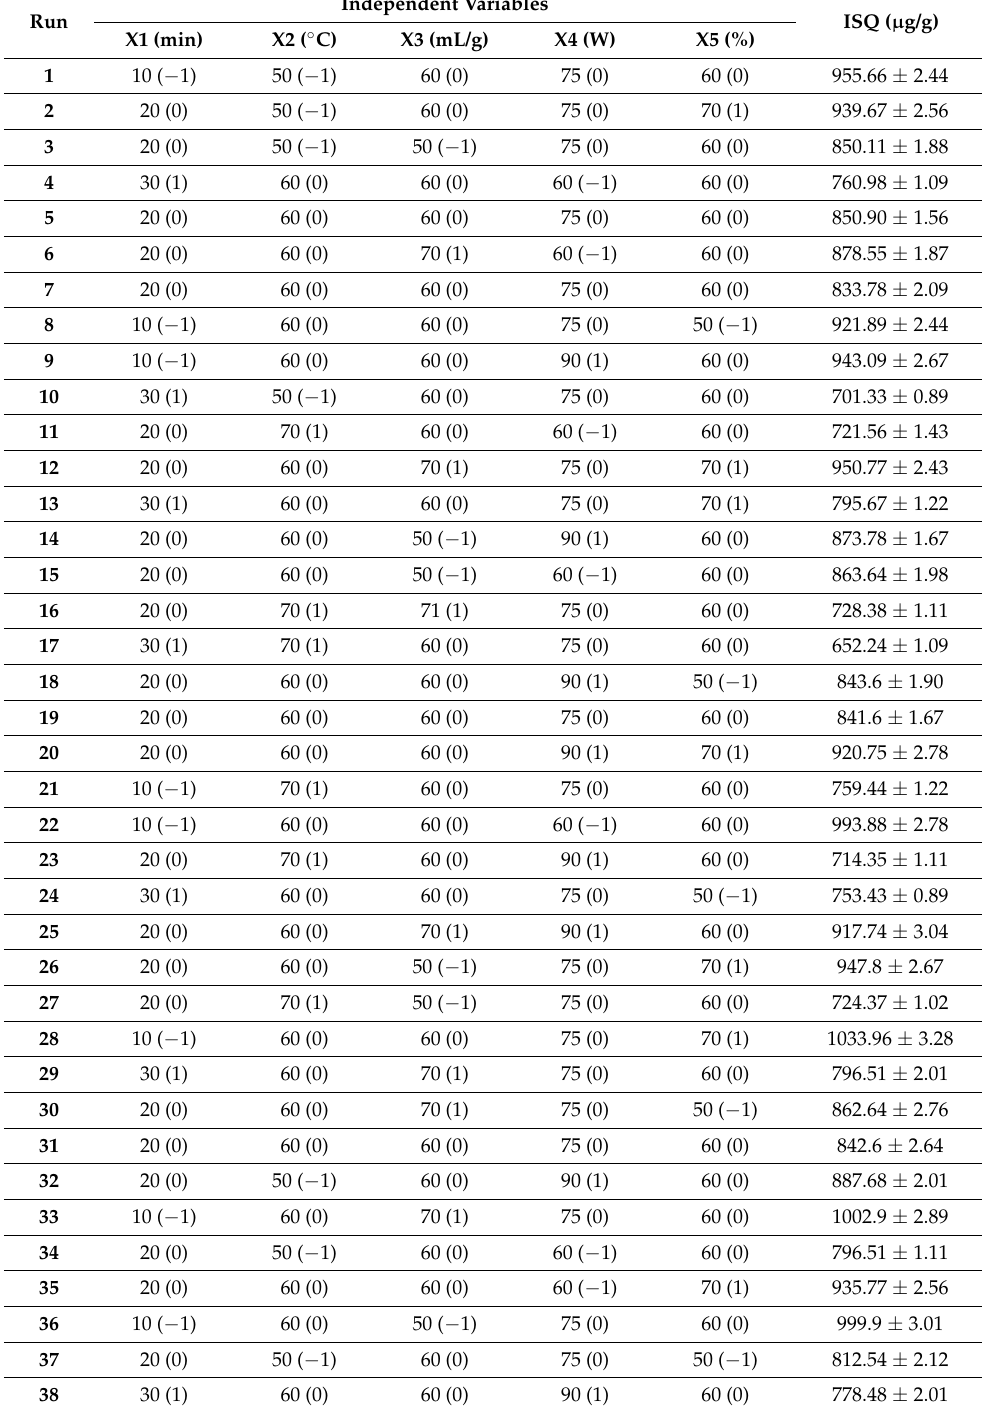
Table 2. Box–Behnken design with independent coded variables and response